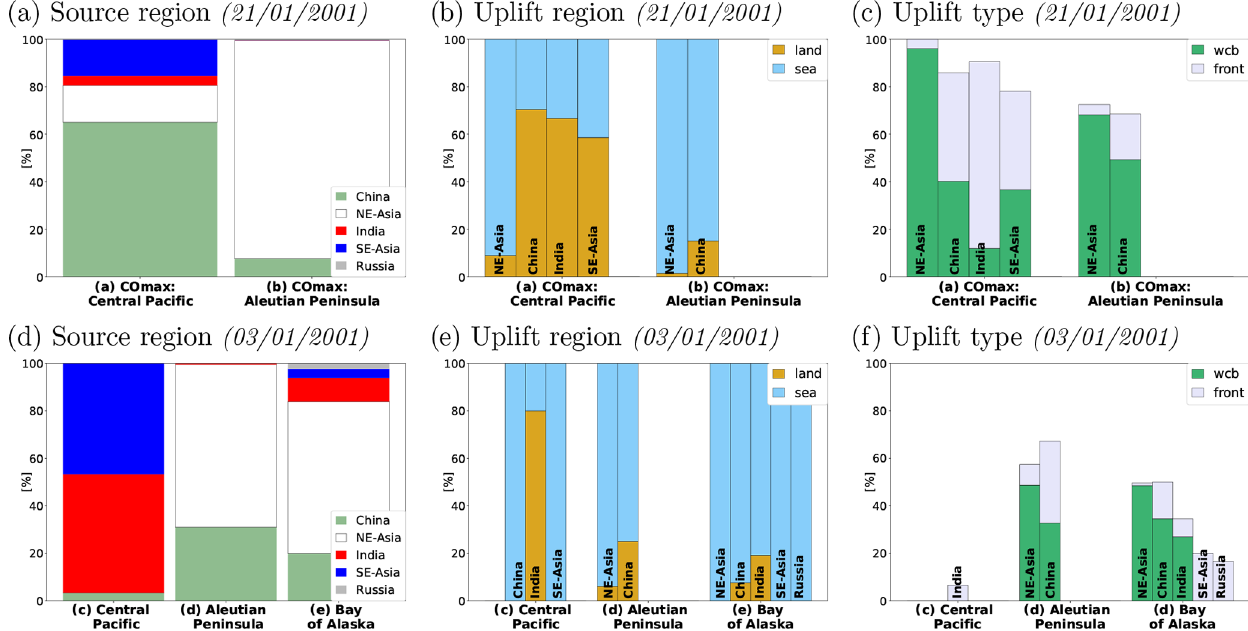
Figure 6. Plots show statistics for both case study days. The x -axis label refers to the different CO maxima clusters shown in Fig. 5. Source regions are shown in Fig.